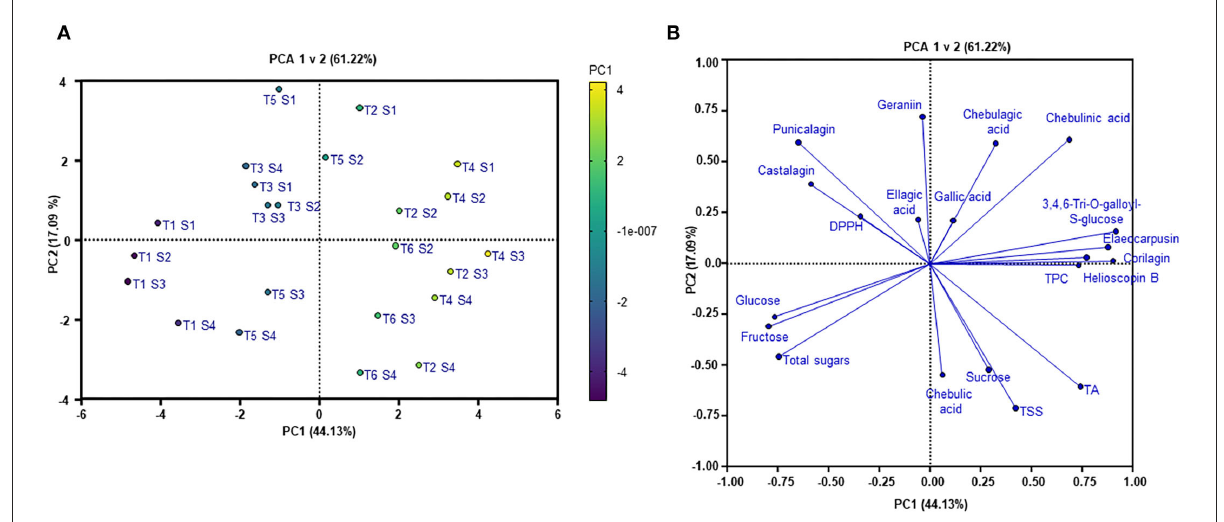
FIGURE7 (A) PCA scores plot and (B) loadings plot. T1–T6, trees; S1–S4, maturity stages; TPC, total phenolic content; DPPH, antioxidant capacity; TA, titratable acidity; TSS, total soluble solid